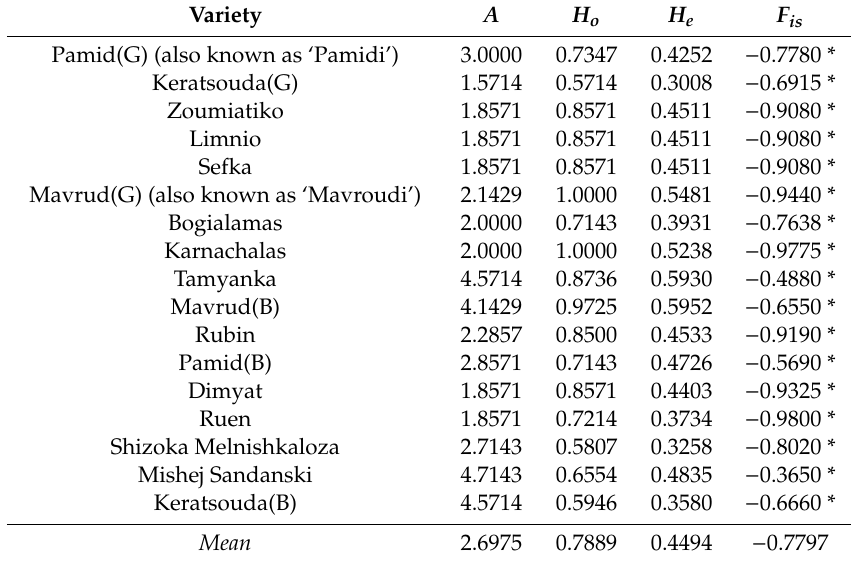
Table 1. Number of alleles ( A ), observed heterozygosity ( H o ), expected heterozygosity ( H e ) and inbreeding coe ffi cient ( F is ) (across all microsatellite loci) for populations under study. Variety A H o H e F is Pamid(G) (also known as ‘Pamidi’) 3.0000 0.7347 0.4252 − 0.7780 * Keratsouda(G)